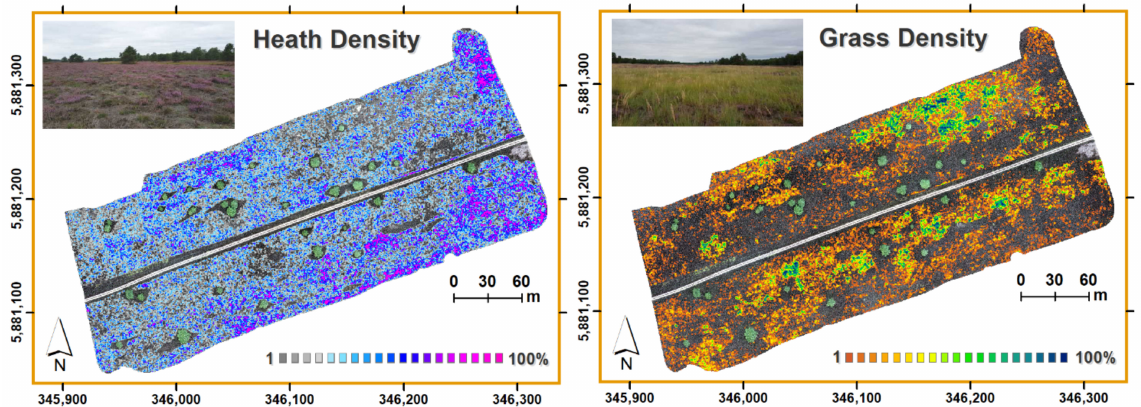
Figure 4. Density maps of two response variables, (left) resprouting Calluna heath and (right) aggregated grass species encroachment on the basis of 1 m 2 sum filtered classification